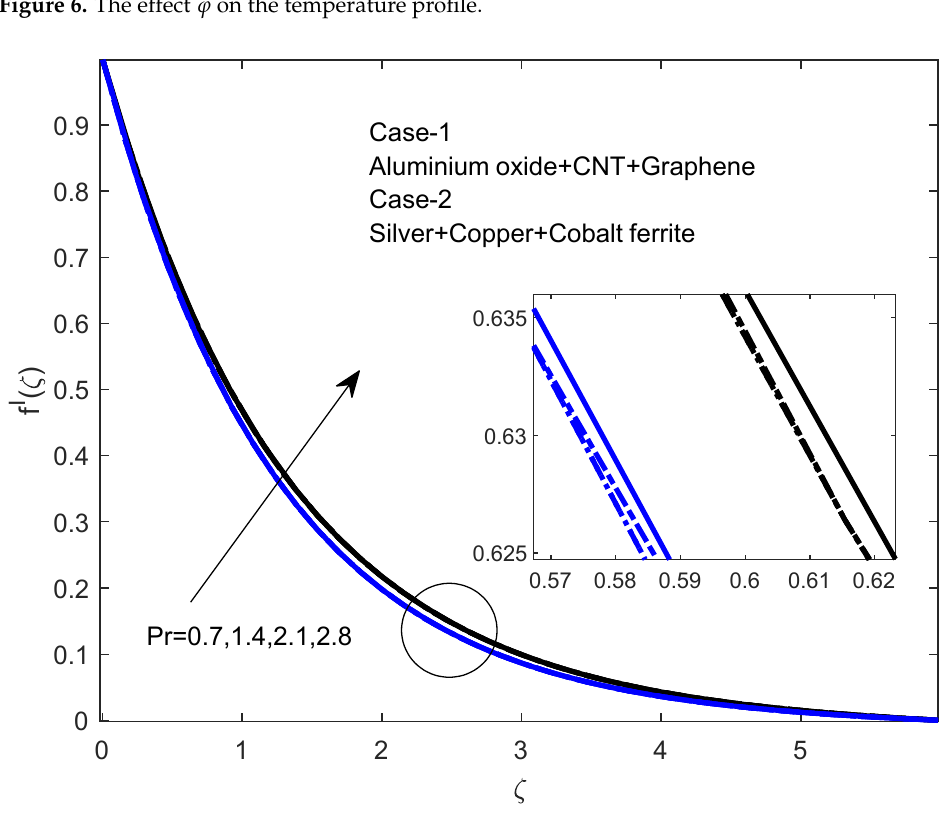
Figure 6. The effect ϕ on the temperature profile.